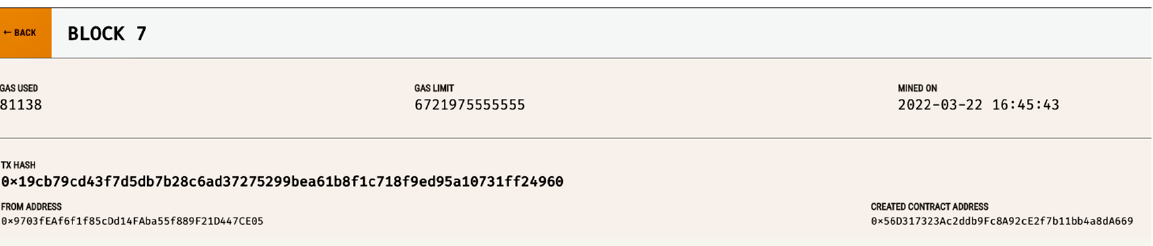
Figure 9. Added block after company creation in Ganache.